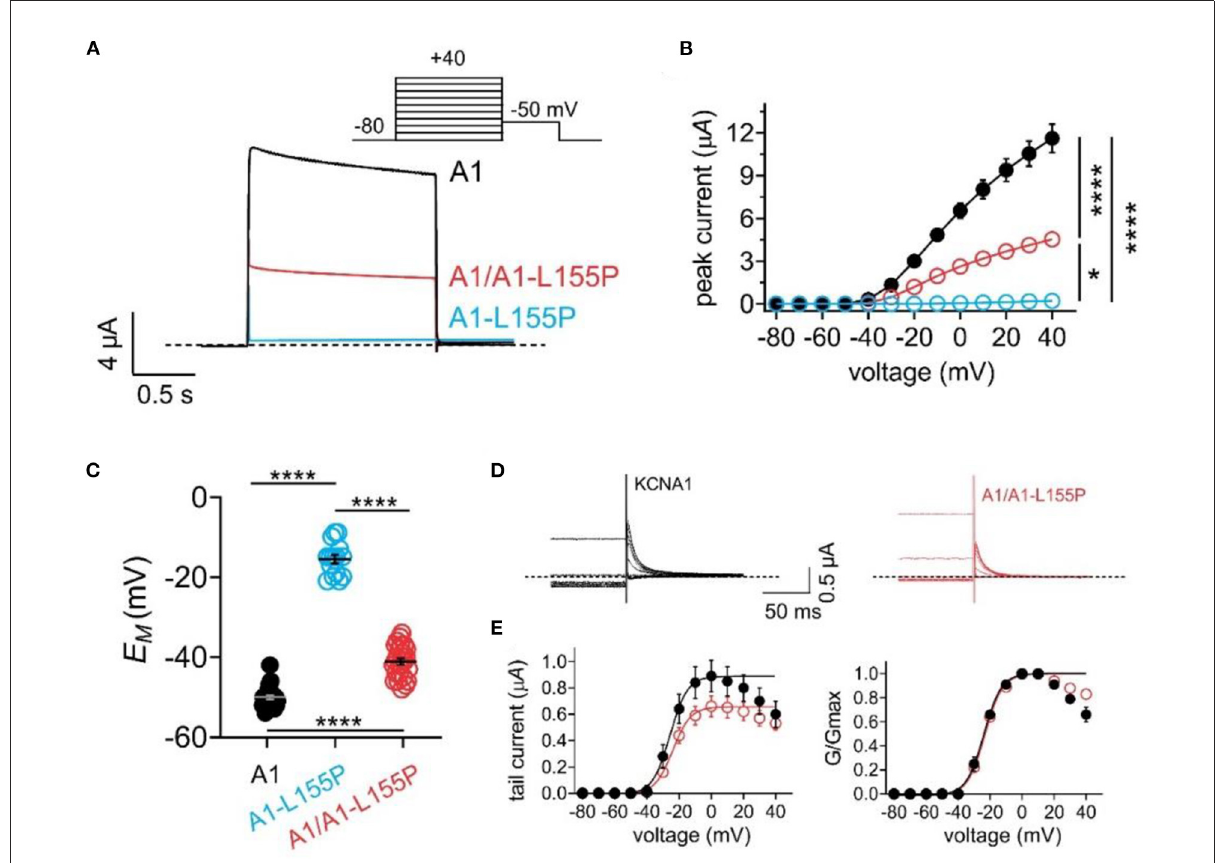
FIGURE2 Effects of L155P on KCNA1 activity. Error bars indicate SEM. n indicates number of oocytes. Statistical comparisons by one-way ANOVA; * P < 0.05; **** P < 0.0001. Dashed line indicates zero current level. (A) Mean traces for wild-type (A1), homozygous mutant (A1-L155P) and heterozygous mutant (A1/A1-L155P) channels expressed in oocytes. Scale bars lower left inset; voltage protocol upper inset; n = 15–29 per group (see Table 1 for values). (B) Mean peak current for traces as in (A) ; n = 15–29 per group (see Table 1). (C) Mean unclamped oocyte membrane potential for oocytes as in (A) ; n = 15–29 per group (see Table 1 for values). (D) Inset showing tail currents at − 50mV after prepulses similar to those shown in (A) . (E) Mean peak tail current (left) and normalized tail current (right) for currents as in (D) ( n = 26–29) (see Table 1 for values).